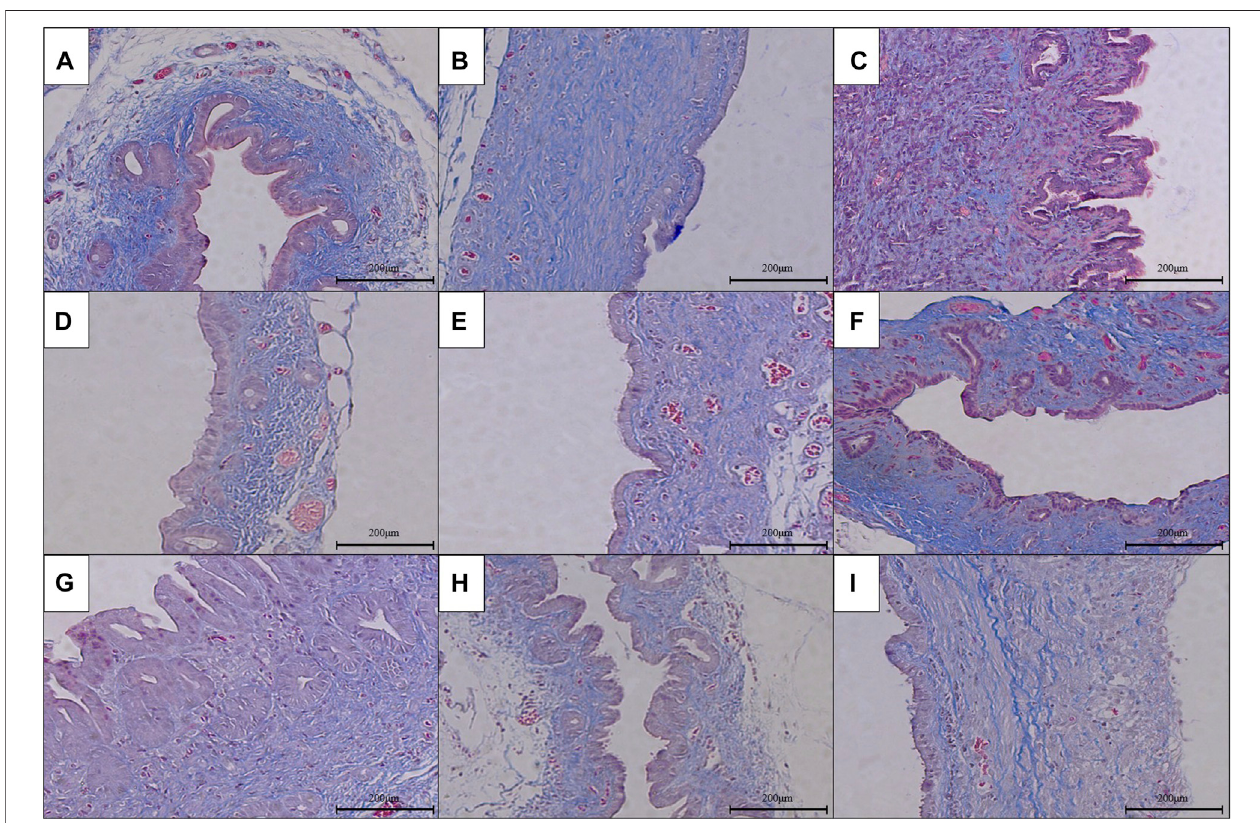
FIGURE 5 | Masson ’ s staining of anastomotic stoma in different groups after the RCJS procedure ( × 200). (A) Sham operation group. (B) Control group at 1 week after the RCJS procedure. (C) Control group at 1 month after the RCJS procedure. (D) Anisodamine intervention group at 1 week after the RCJS procedure. (E) Anisodamine intervention group at 1 month after the RCJS procedure. (F) Neostigmine intervention group at 1 week after the RCJS procedure. (G) Neostigmine intervention group at 1 month after the RCJS procedure. (H) Combination group at 1 week after the RCJS procedure. (I) Combination group at 1 month after the RCJS